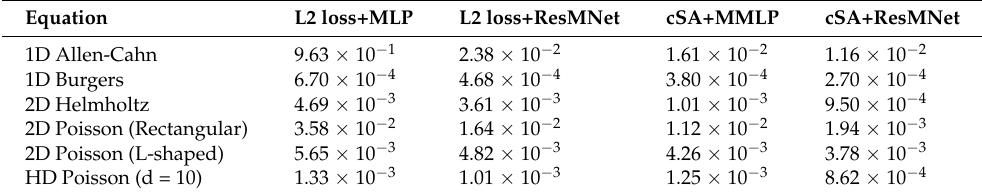
Table 4. Relative L 2 errors of different loss functions and different